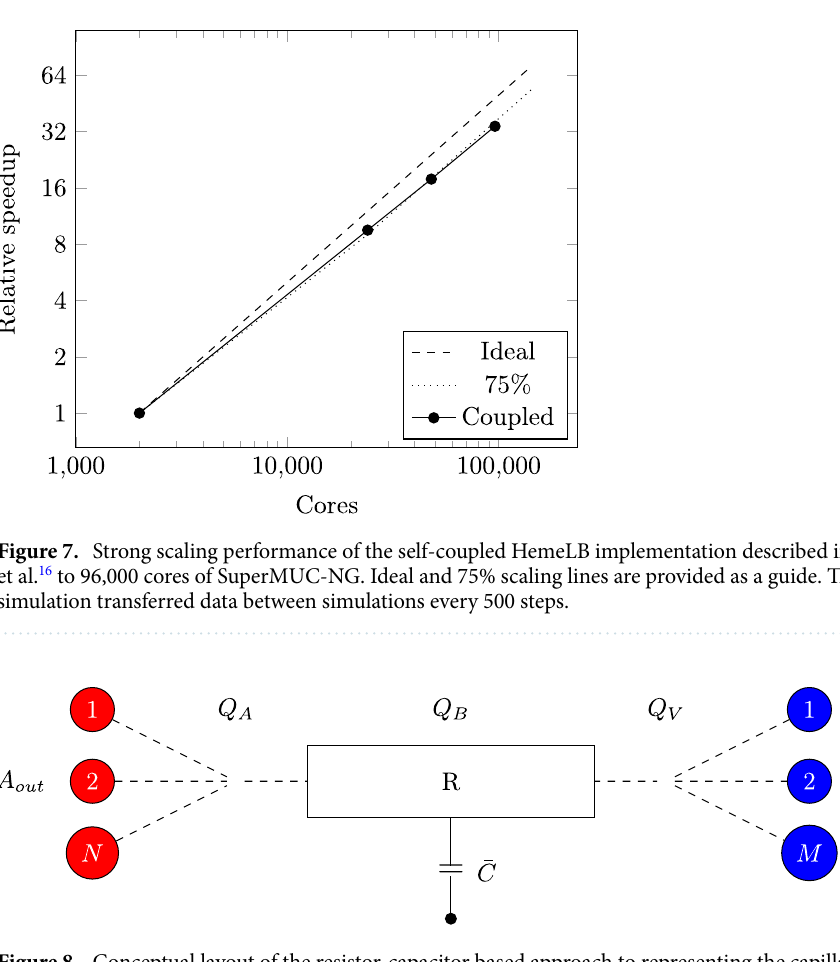
¯ C , can be viewed as an